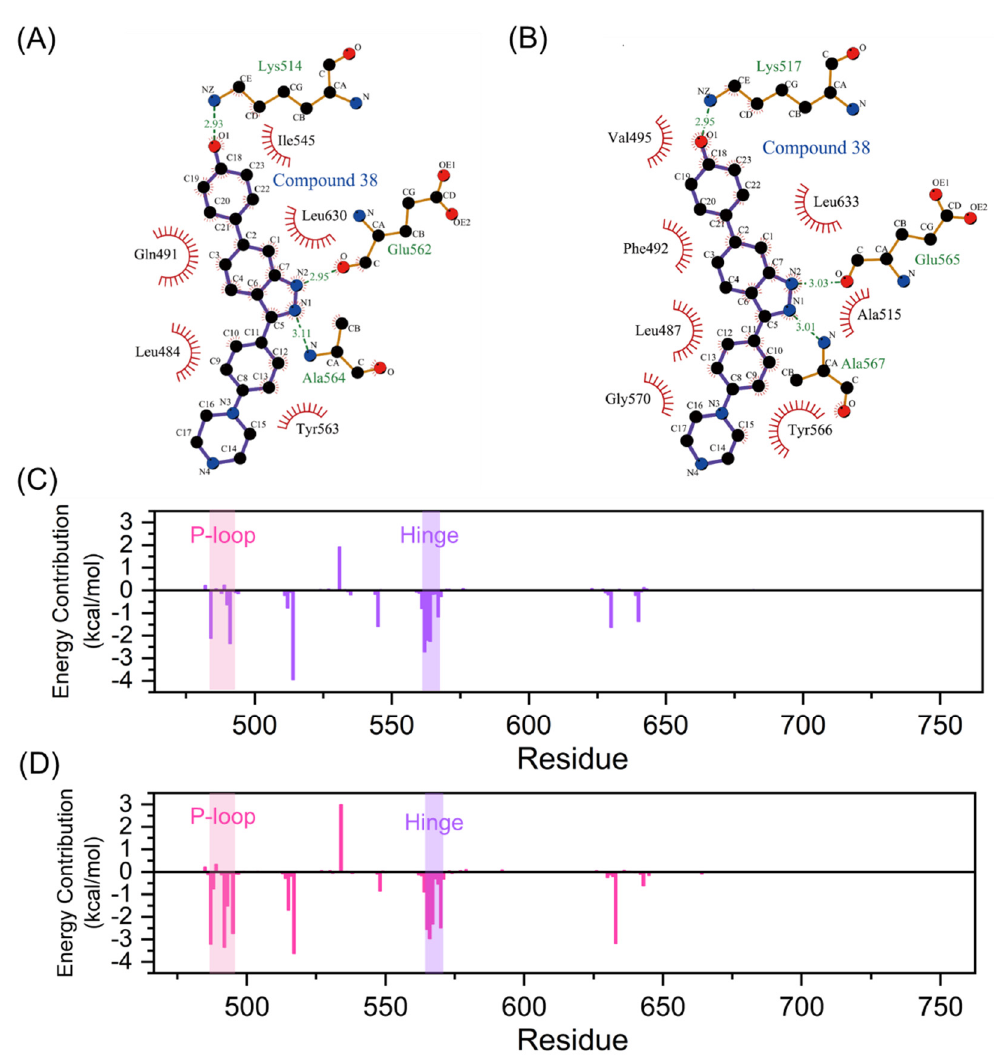
Figure 6. Intermolecular forces between FGFR and compound 38. Hydrogen bonds and hydrophobic interactions of FGFR1-38 ( A ) and FGFR2-38 ( B ) complexes are visualized by LigPlot+. Hydrogen bonds and hydrophobic interactions are shown as green dashed lines and red arcs, respectively. Residue contributors to the binding free energy of compound 38 to FGFR1 ( C ) and FGFR2 ( D ) calculated by the MM-GBSA method. The P-loop and hinge region are marked with pink and purple backgrounds, respectively.